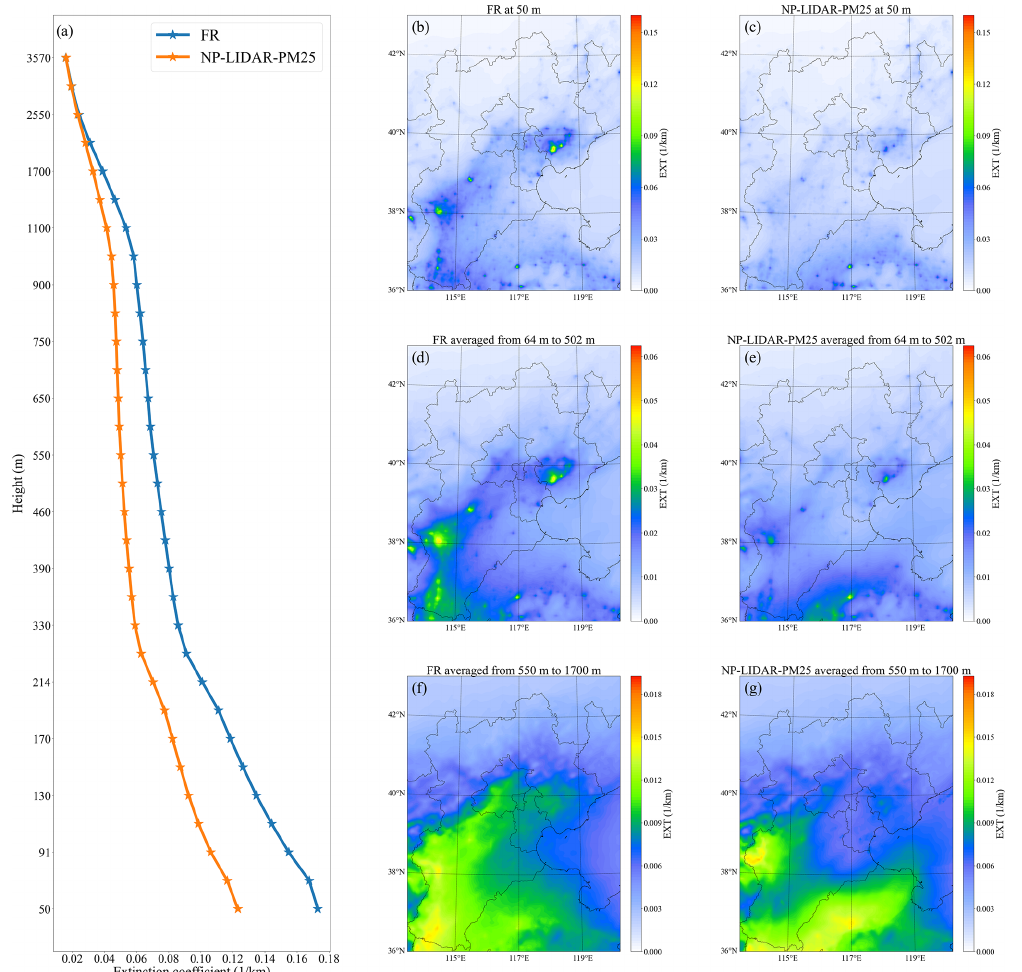
Figure 15. Vertical profile of the analysis ensemble spread of extinction coefficients averaged among DA sites in the FR and NP-LIDAR- PM25 experiments (a) . The spatial distribution of the analysis ensemble spread of extinction coefficients at 50m in the FR experiment (b) , at 50m in NP-LIDAR-PM25 (c) , averaged from 64 to 502m in FR (d) , averaged from 64 to 502m in NP-LIDAR-PM25 (e) , averaged from 550 to 1700m in FR (f) , and averaged from 550 to 1700m in NP-LIDAR-PM25. All results are averaged over 1–30 April